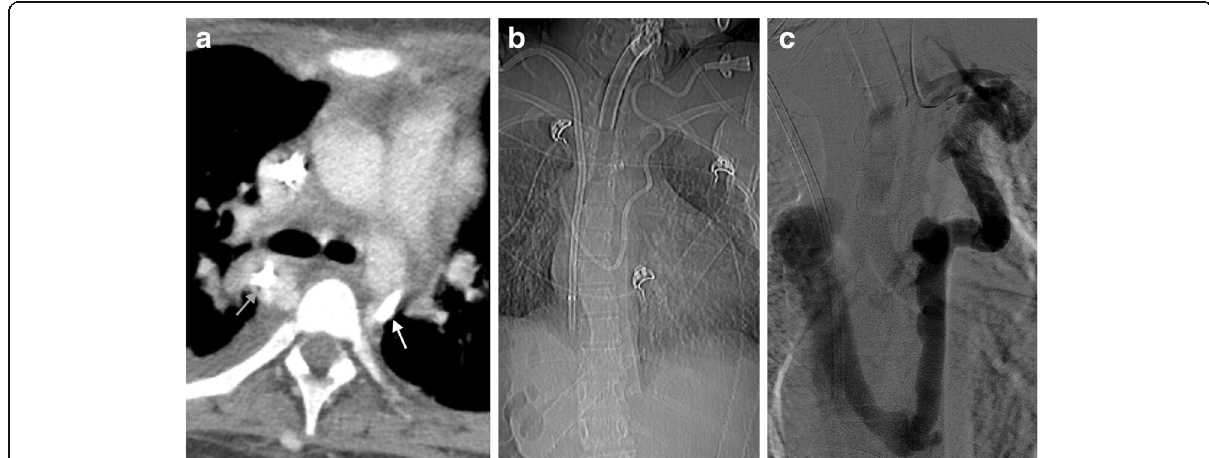
Fig. 13 Collateral placement of central lines. a Axial CT image demonstrating placement of a central line through the hemiazygous (white arrow) and azygos vein (gray arrow). b CT scout image showing the tortuous path the line takes through the collateral vessels to the right atrium. c Interventional venogram of the same patient demonstrating collateral placement of the line